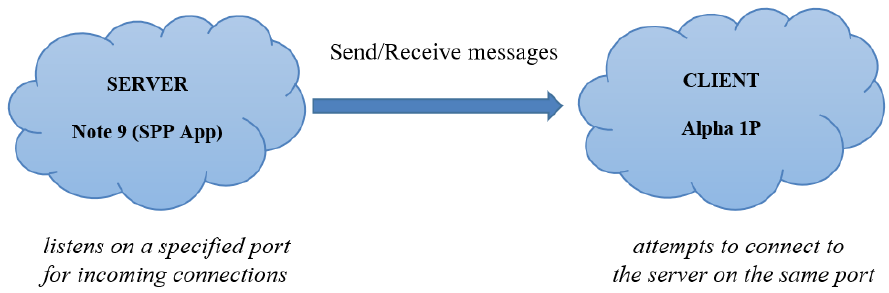
Figure 15. Server – client communication.